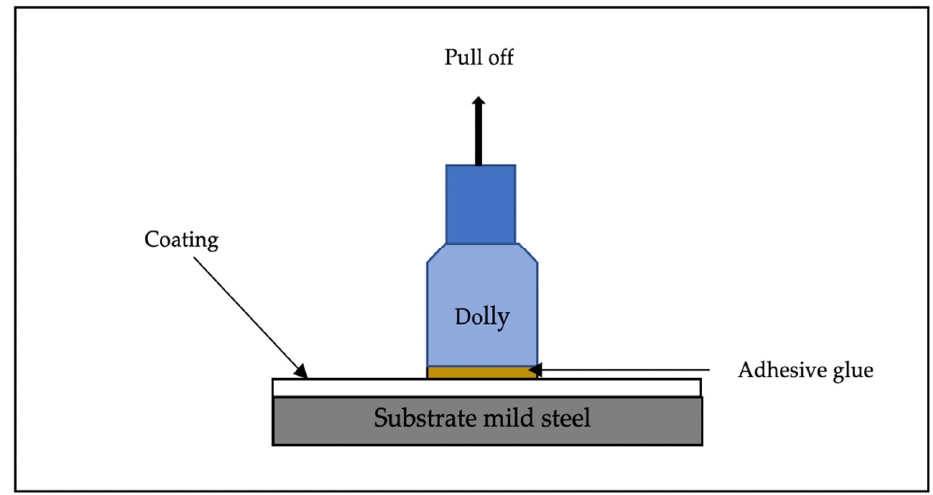
Figure 3. Schematic diagram of adhesion test.